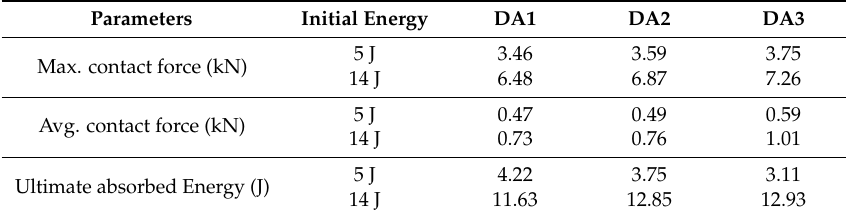
Table 5. The impact parameters of the specimens of DA1/DA2/DA3 under the two impact energies. Parameters Initial Energy DA1 DA2 DA3 Max. contact force